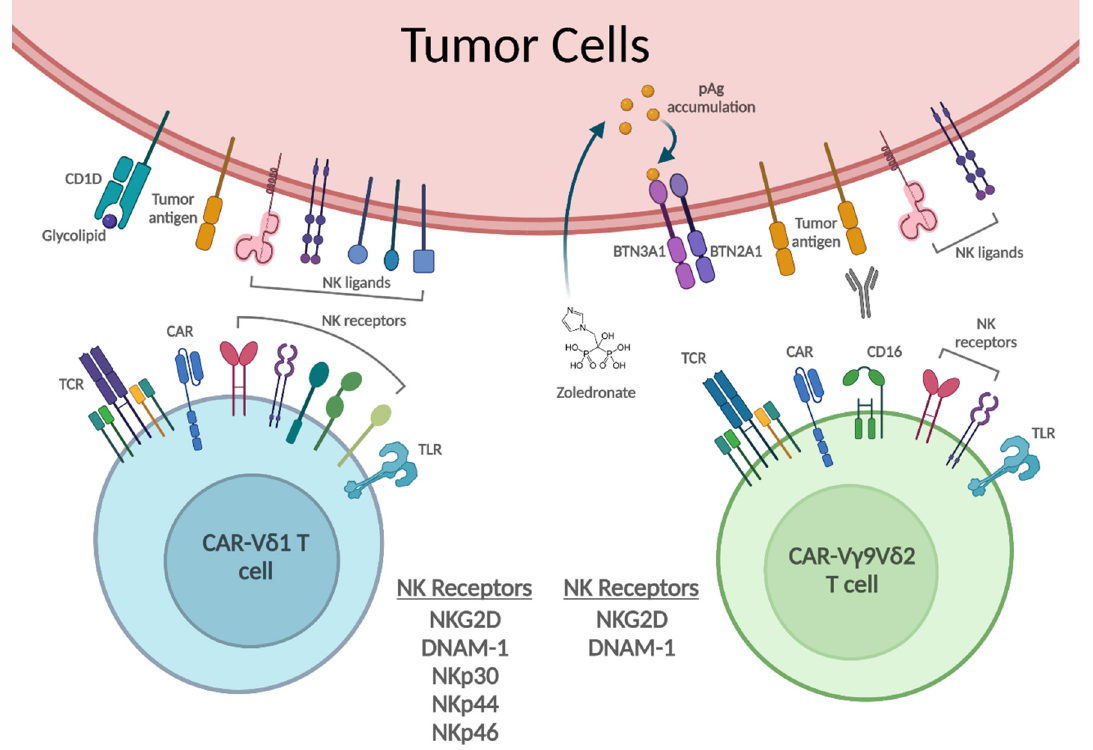
Figure 1. The tumor cell recognition of CAR- γδ T cells. CAR- γδ T cells recognize tumor cells through multiple receptor pathways, increasing their cytolytic potential and resistance to immunosuppression. Both V δ 1+ and V γ 9V δ 2 TCR possess MHC-nonrestricted cytotoxicity. The V δ 1 TCR recognizes lipid antigens presented on CD1 molecules, and the V γ 9V δ 2 TCR recognizes intracellular pAg-bound BTN3A1/2A1 complex. V γ 9V δ 2 T cells express CD16 (Fc γ RIII), which binds the Fc region of IgG antibodies to induce antibody-dependent cellular cytotoxicity (ADCC). TLRs (Toll-Like Receptors) form another axis of immune cell coordination with each binding pathogen- or damage-associated molecular patterns (PAMPs/DAMPs), simultaneously increasing γδ T cell cytotoxicity and coor- dinating with surrounding dendritic cells (DCs). NK receptor pathways expressed on the cells enable cytolytic activity in response to expressed markers of DNA damage, stress, or infection. Both V δ 1+ and V γ 9V δ 2 T cells express NKG2D, which recognizes cellular distress ligands presented on MIC(A/B) and ULBP1-6, and DNAM-1, which binds CD155 and CD112. In addition, V δ 1+ T cells express NKp30, NKp44, and